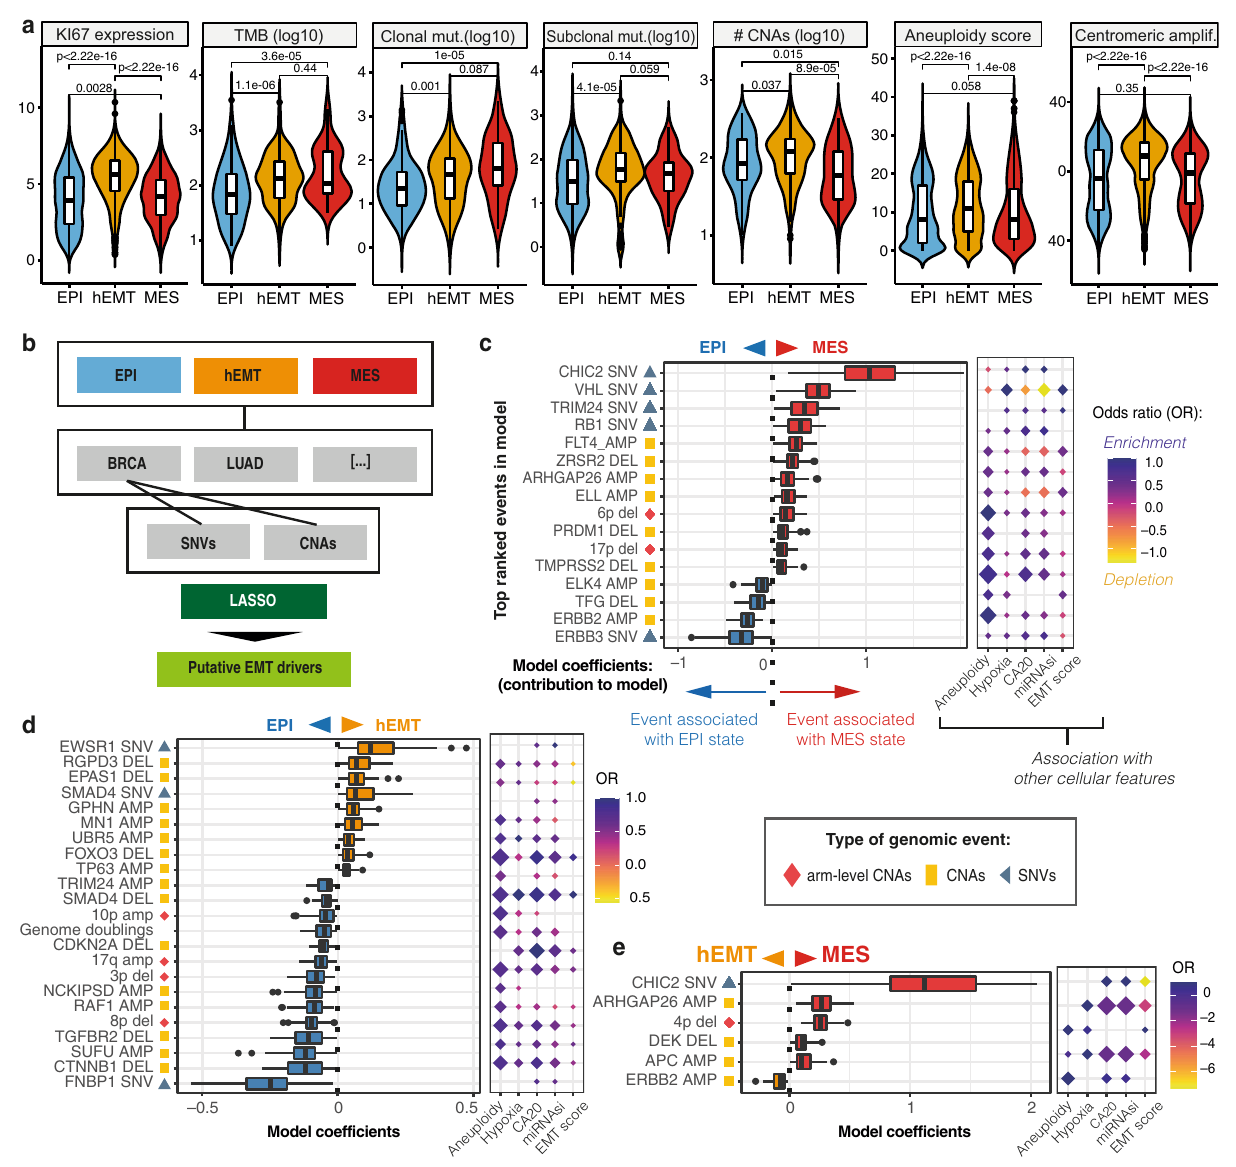
Fig. 3 | GenomichallmarksofEMT.a Expression of the proliferationmarker Ki67, tumour mutational burden (TMB), number of clonal/subclonal mutations (mut.), copy number aberration (CNA) burden, aneuploidy and centromeric ampli fi cation (amplif.) levels compared across biologically independent samples from TCGA in the epithelial ( n =3080), hEMT ( n =2856), mesenchymal ( n =1006) states. The centerline of boxes depicts the median values; the bottom and top box edges correspond to the fi rst and third quartiles. Two-sided Wilcoxon signed-rank test p values are displayed. b The analytical work fl ow used to detect genomic events linkedwithEMT.Foreachstateandcancertype,weuseddNdScv,singlenucleotide variants (SNVs) and copy number alterations (CNAs) enrichment to prioritise mutated genes and copy number events, respectively. These genomic events were then employed as input for lasso modelling to classify EMT states. c Top-ranked genomic markers distinguishing the mesenchymal ( n =822) from the epithelial